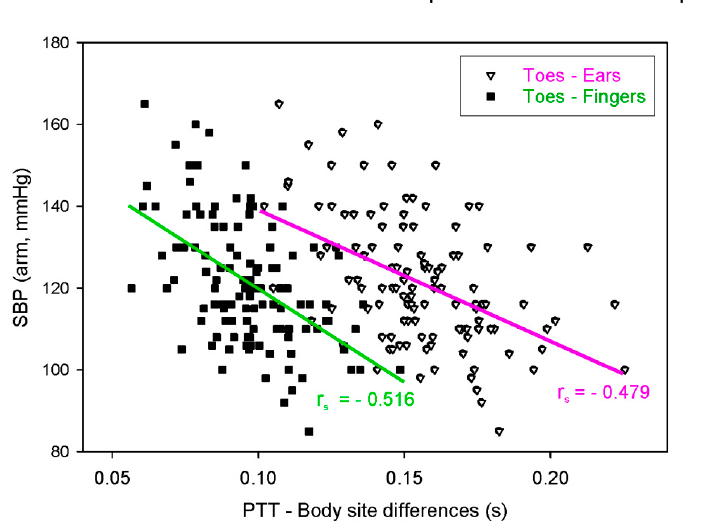
Figure 2. Dual probe multi-site PPG-derived pulse transit time (PTT) correlation with systolic blood pressure (SBP). The data used in this figure were adapted from Allen and Murray [19].